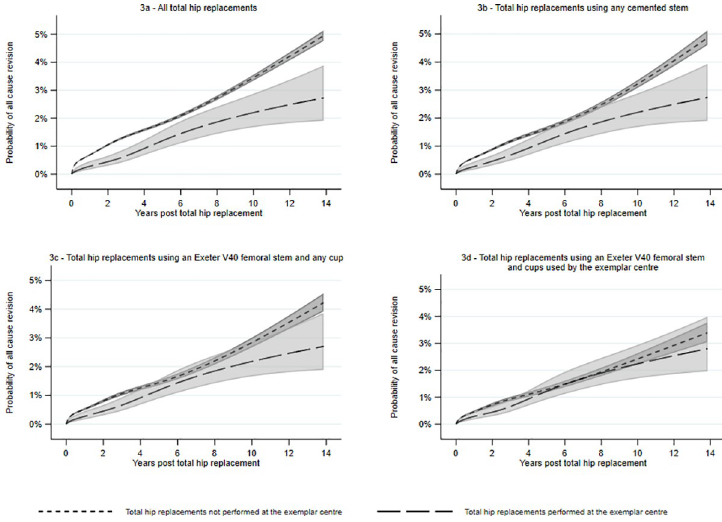
Fig 3. FPSA adjusted for age, sex, and American Society of Anesthesiology score. Results presented for a 68-year- old female patient with an American Society of Anesthesiology score of 2. FPSA, flexible parametric survival analysis.